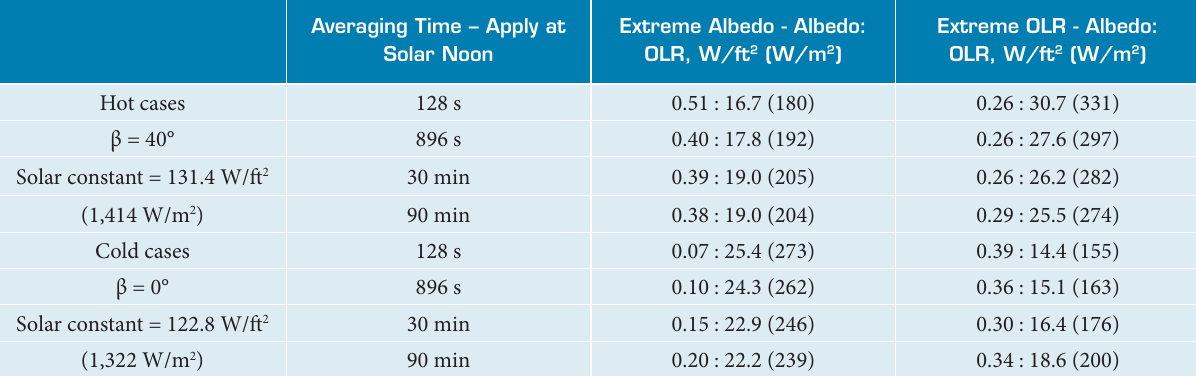
spacecraft’s position vector in the orbital plane and the Earth-Sun